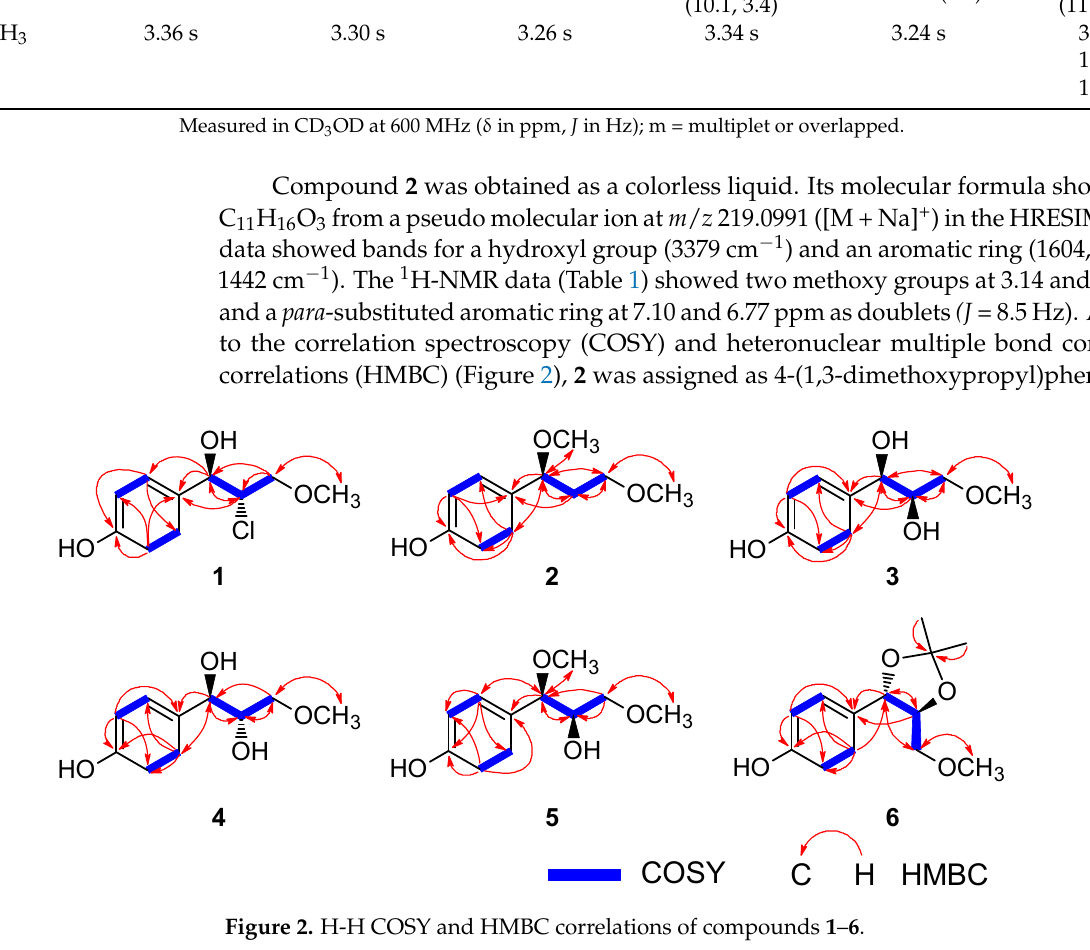
Table 2. 13 C-NMR spectroscopic data for compounds 1 – 6.